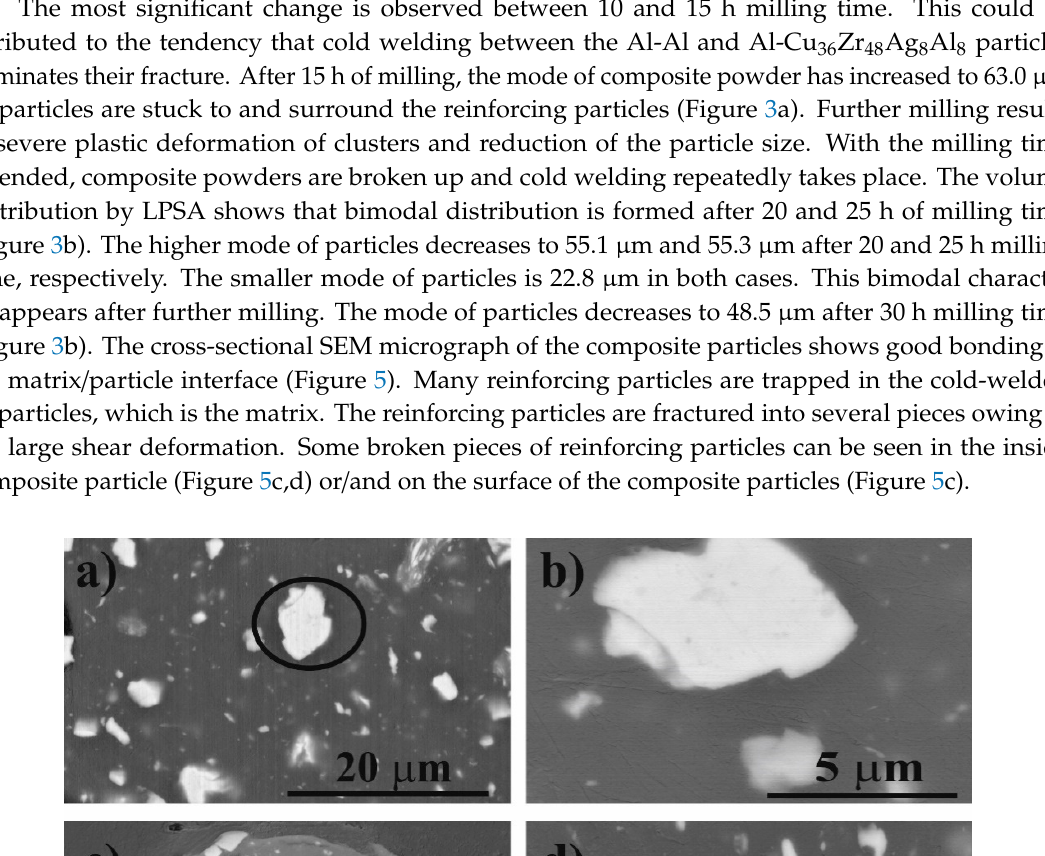
Figure 6. Particle sizes D 0.1 , D 0.5 , and D 0.9 of the composite as a function of the milling time (D 0.1 , D 0.5 , and D 0.9 diameters correspond to 10, 50, and 90% fineness of the particle size volume distribution, respectively). With the milling time extended, the ductile Al particles become harder due to the cold work of the balls. The composite powder is repeatedly broken and cold-welded. Between 15 and 20 h of milling time, fracturing is the determining factor that causes reduction in the particle size. Observing the median of the particle size distribution, a steady state is reached after 25 h milling time.